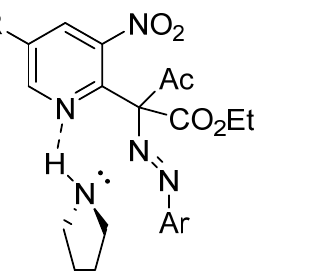
Figure 6. Possible factors affecting reaction pathway.